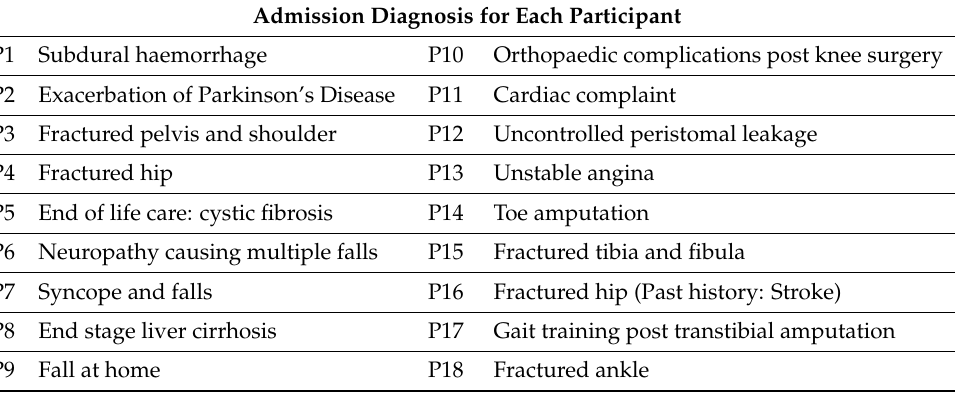
Table 1. Admission diagnosis for each participant (Code: P1 = Participant 1, P2 = Participant 2).